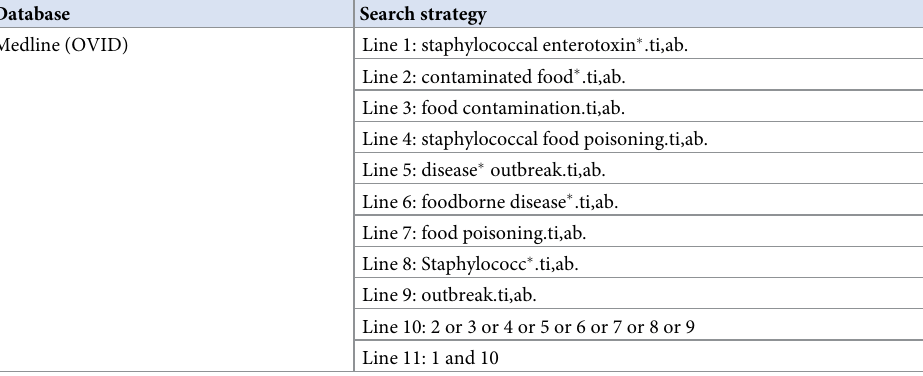
Table 2. Search strategy applied on Medline